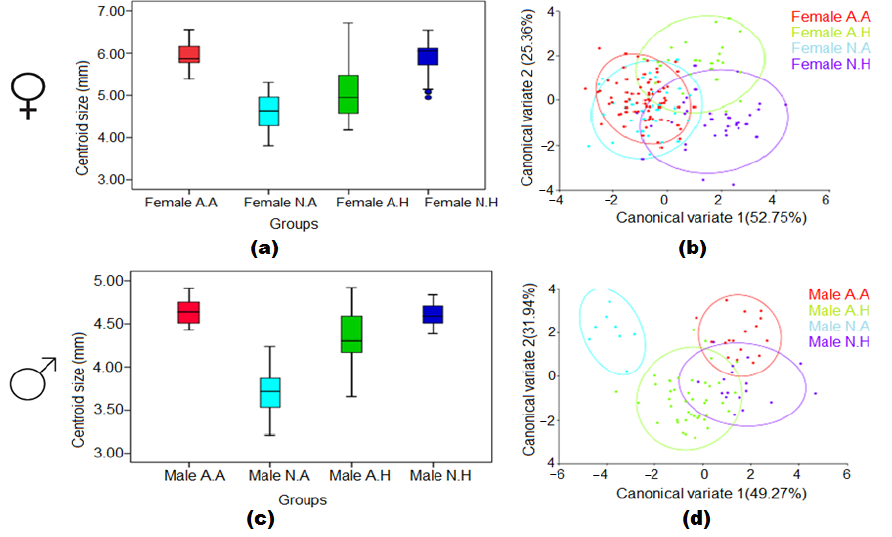
Figure 6. Boxplots of wing centroid size and wing shape diagram of the first two canonical variables between the interaction of climate and breeding sites in female ( a , b ) and male ( c , d ) Cs. longiareolata mosquitoes. Group A.A: Artificial Breeding site , Climate Sub-Arid ; Group N.A: Natural Breeding site , Climate Sub-Arid ; Group A.H: Artificial Breeding site , Climate Sub-Humid ; Group N.H: Natural Breeding site , Climate Sub-Humid.